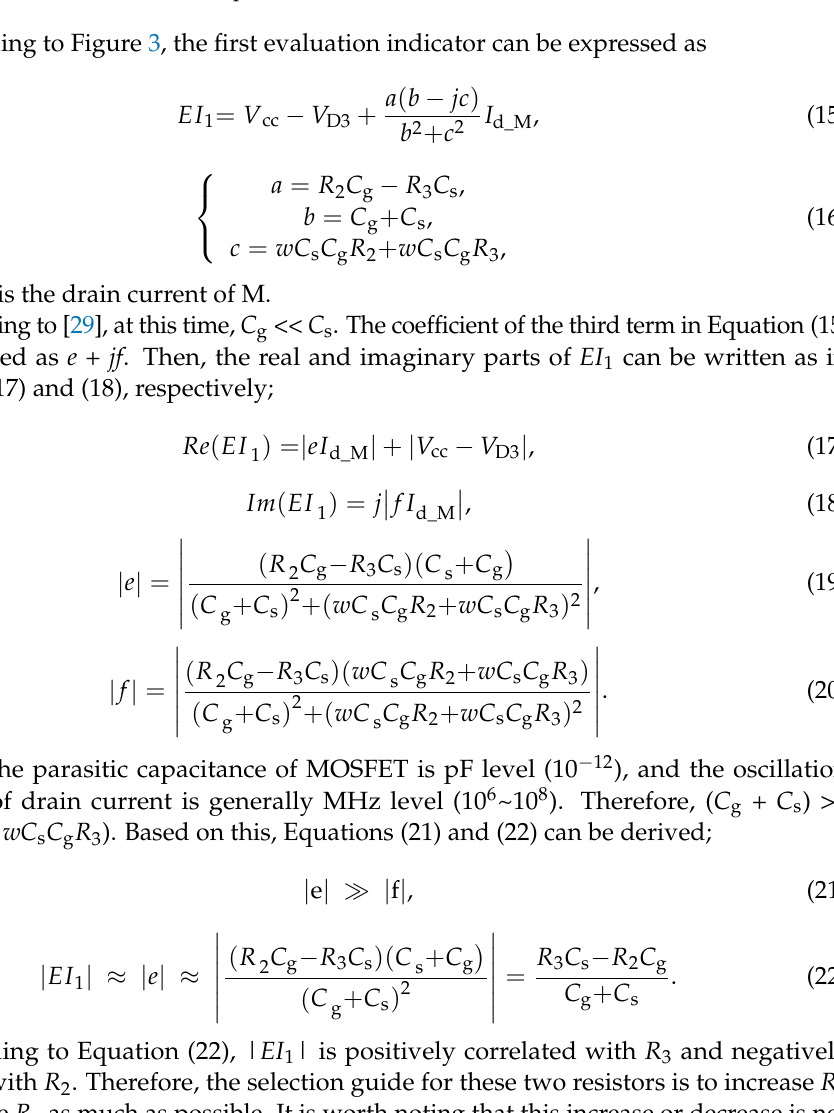
Figure 3. Equivalent circuit of the improved DVCC.